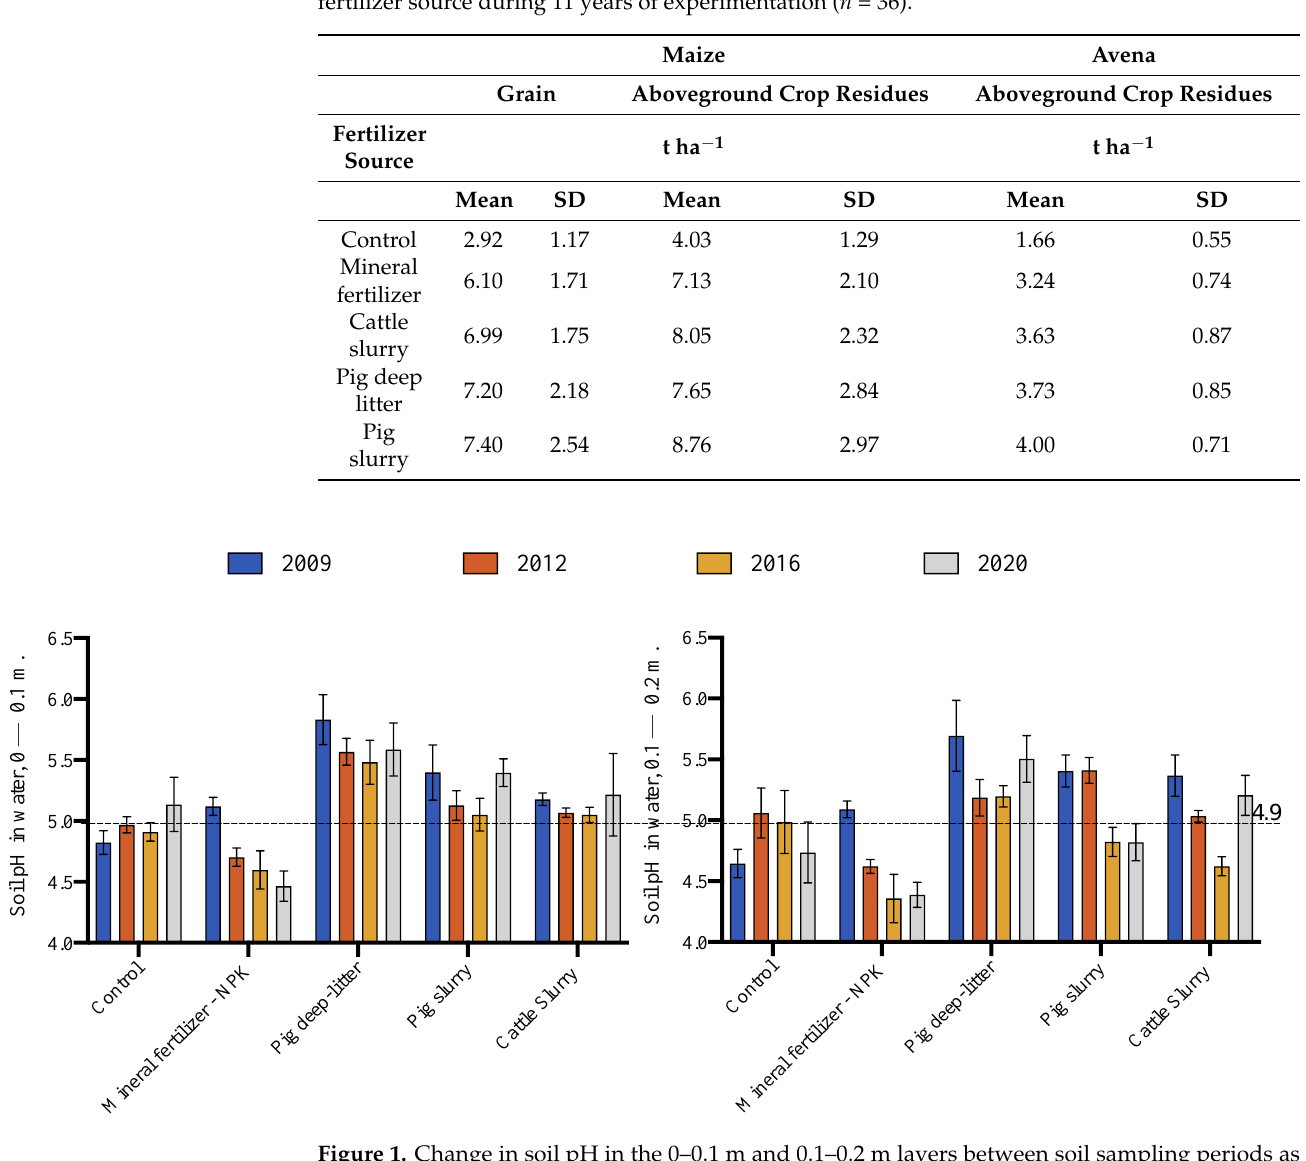
Table 3. Mean and standard deviation (SD) of grain and aboveground crop residues as related to fertilizer source during 11 years of experimentation ( n = 36).